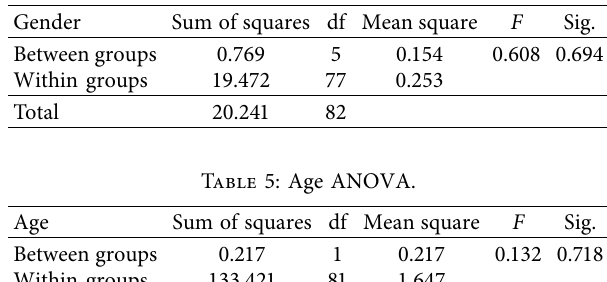
Table 4: Gender ANOVA. Table 3: MRSA frequencies in the current study.